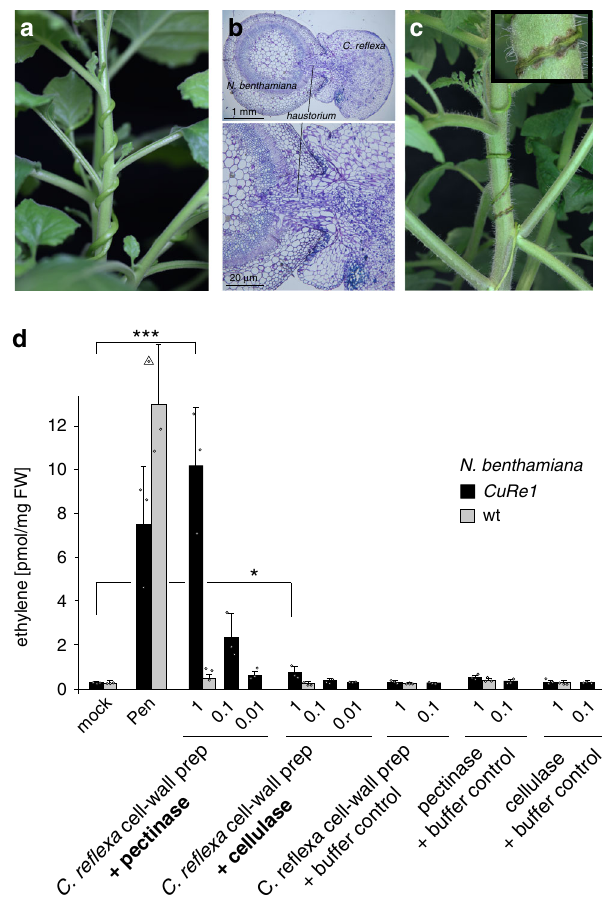
Fig. 1 Cuscuta re fl exa induces defense in cultivated tomato by a pathogen-associated molecular pattern. a C. re fl exa can infect nearly all dicot plants as susceptible hosts; picture shows infected Nicotiana benthamiana ; b Parasitic haustoria successfully penetrate the N. benthamiana shoot; c C. re fl exa induces visible hypersensitive response (HR) on tomato ( S. lycopersicum ) shoot at the contact sites of the parasite ’ s haustoria. d C. re fl exa cell wall preparations were treated with either cellulase or pectinase; extracts were applied to trigger defense-related ethylene biosynthesis in transgenic CuRe1 -expressing N. benthamiana plants. Numbers on x-axis indicate applied extract volume in µ l; bovine serum albumin (BSA; 0.01 mg/ml) buffered in 25 mM MES (pH 5.7) was added as mock control; Penicillium extract (0.05 mg/ml) served as positive control 31 . FW, fresh weight. Ethylene measurements show means of three technical replicates; error bars denote SD. Wildtype (wt) N. benthamiana plant samples have not been tested with diluted extract preparations (0.1 µ l and 0.01 µ l) since they did not respond to maximum doses (1 µ l) in the ethylene assay. Dots indicate single data points, triangle shows outlier at 16.87; Asterisks show Student ’ s t test; *** p < 0.0028; * p < 0.0285; representative graphs are shown; all experiments were repeated more than three